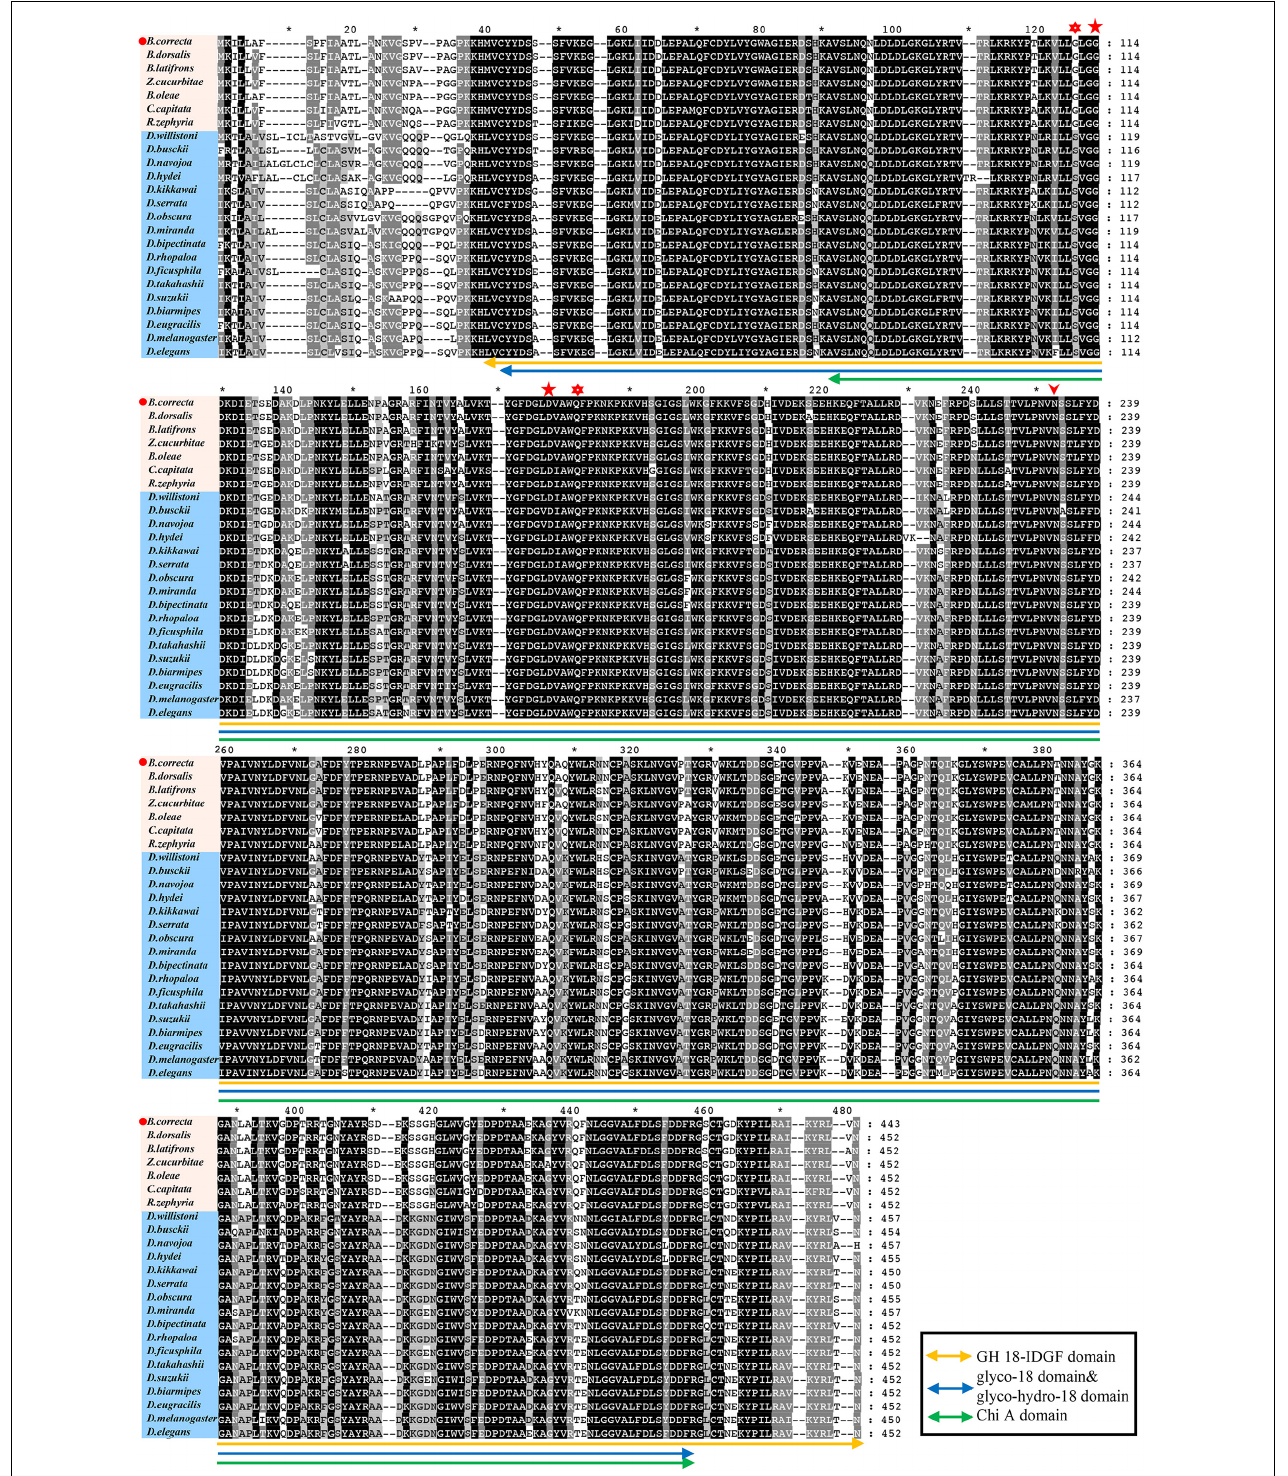
FIGURE 1 | Protein sequence alignments of IDGF6 proteins in Drosophilidae and Tephritidae fruit flies based on NCBI BLAST results. The alignments that present one predicted and conserved domain similar to ChiA chitinases, the glycoside hydrolase 18 (GH18) family of chitinases. Asterisks and star indicate the positions of residues that have been shown to be required for catalytic activity in bacterial chitinase (Watanabe et al., 1993). For the species both in Drosophilidae and Tephritidae, the second and third (star) match the required residues in chitinases, but the fourth (asterisks) is E in chitinases while Q in IDGFs. As for the first (asterisks), in Drosophilidae it is S, which matches the required residues in chitinases, but in Tephritidae it is G. All species IDGF sequences contain single consensus motif (arrowhead) for N-linked glycosylation (Kirkpatrick et al., 1995) that is missing in chitinase.